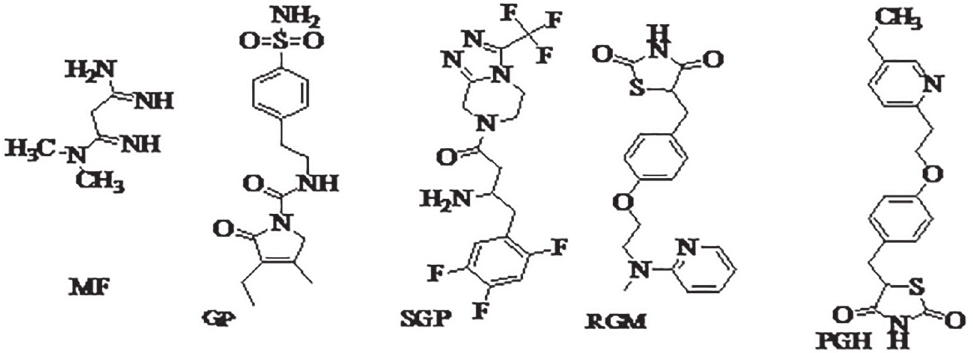
FIGURE 1 - Structure of the studied